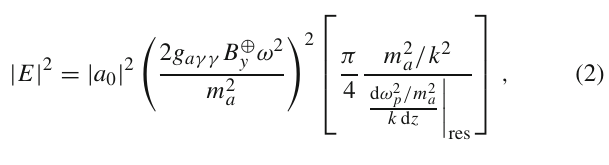
takes place at the lowest altitudes (details on how Eq. 1